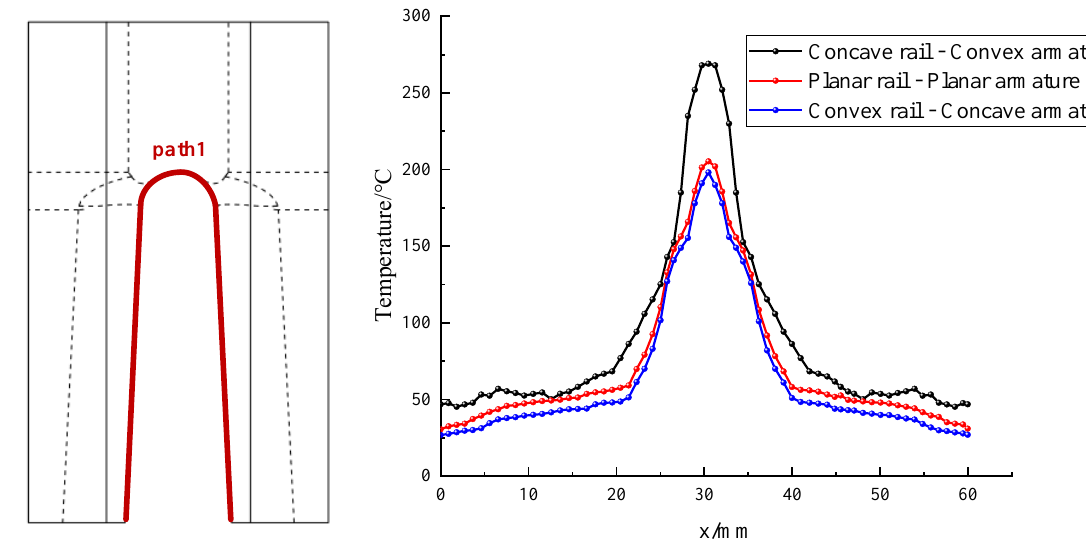
FIGURE 8. Schematic diagram of path 1 and temperature